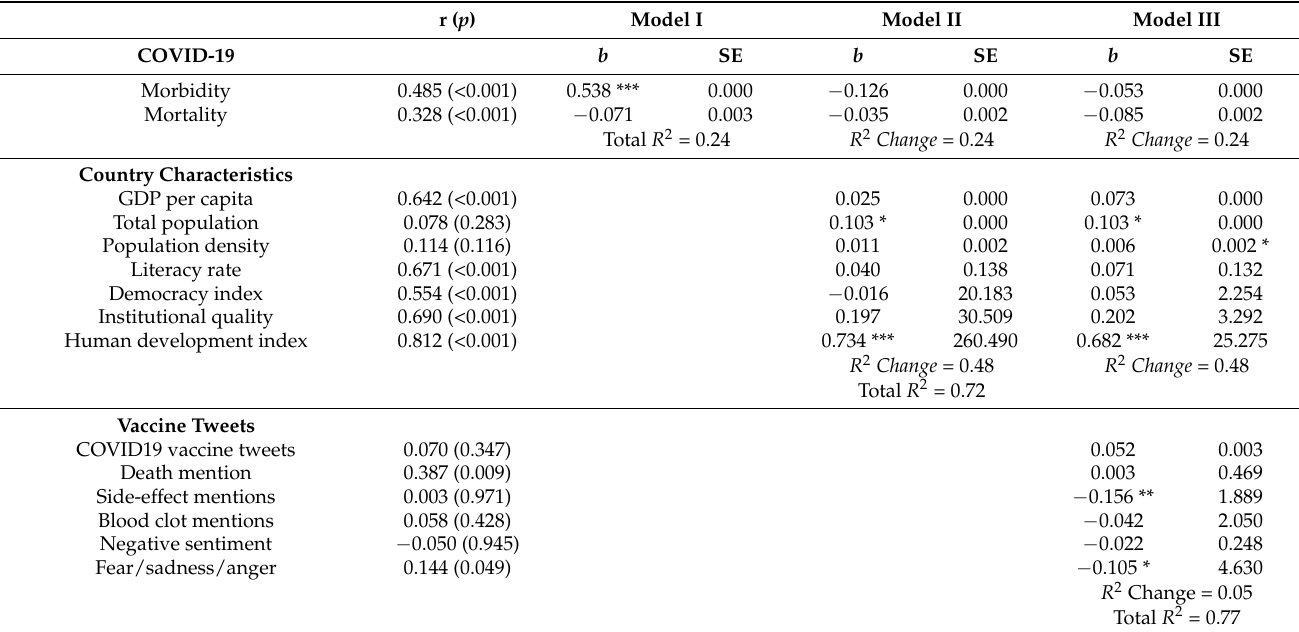
Table 4. Predictors of vaccination